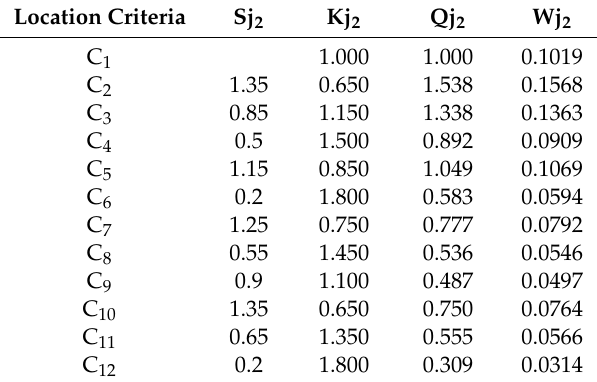
Table 12. Response of the second member of the EE panel.